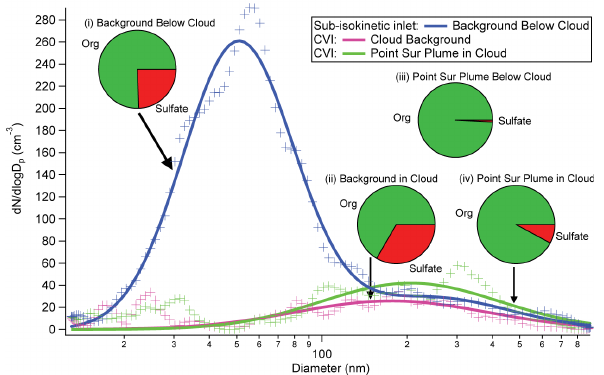
Fig. 9. DMA size distribution and AMS chemical composition mea- surements during Flight 6 from Figs. 7 and 8. The DMA data col- lected downstream of a sub-isokinetic inlet below cloud were fit to a two-term log-normal function while the size distributions down- stream the CVI were fit to a single-term log-normal function for data greater than 50nm diameter. The DMA raw data are also included for each of the log-normal fits. Only sulfate and non-refractory or- ganics were observed above detection limits by the AMS, and their relative mass concentrations are depicted in the pie charts for four different conditions: (i–ii) background marine aerosol below cloud and in cloud behind the CVI; (iii–iv) R/V Point Sur smoke below cloud and in cloud behind the CVI. DMA data are not available for the R/V Point Sur smoke below cloud since those crossings were too narrow for an entire DMA scan ( ∼ 110s) to